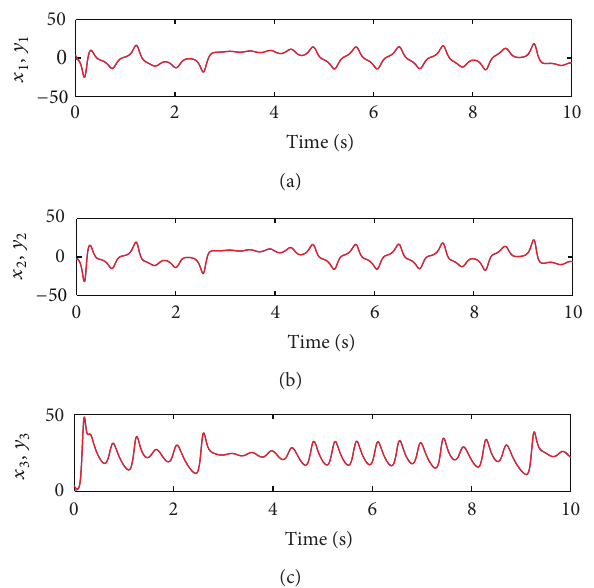
Figure 9: Synchronization of fractional-order unified chaotic system in the presence of systematic uncertainties and external disturbances with 𝛼 = 0.5 (blue line represents the trajectories of the drive system, while red line represents the trajectories of the response system).